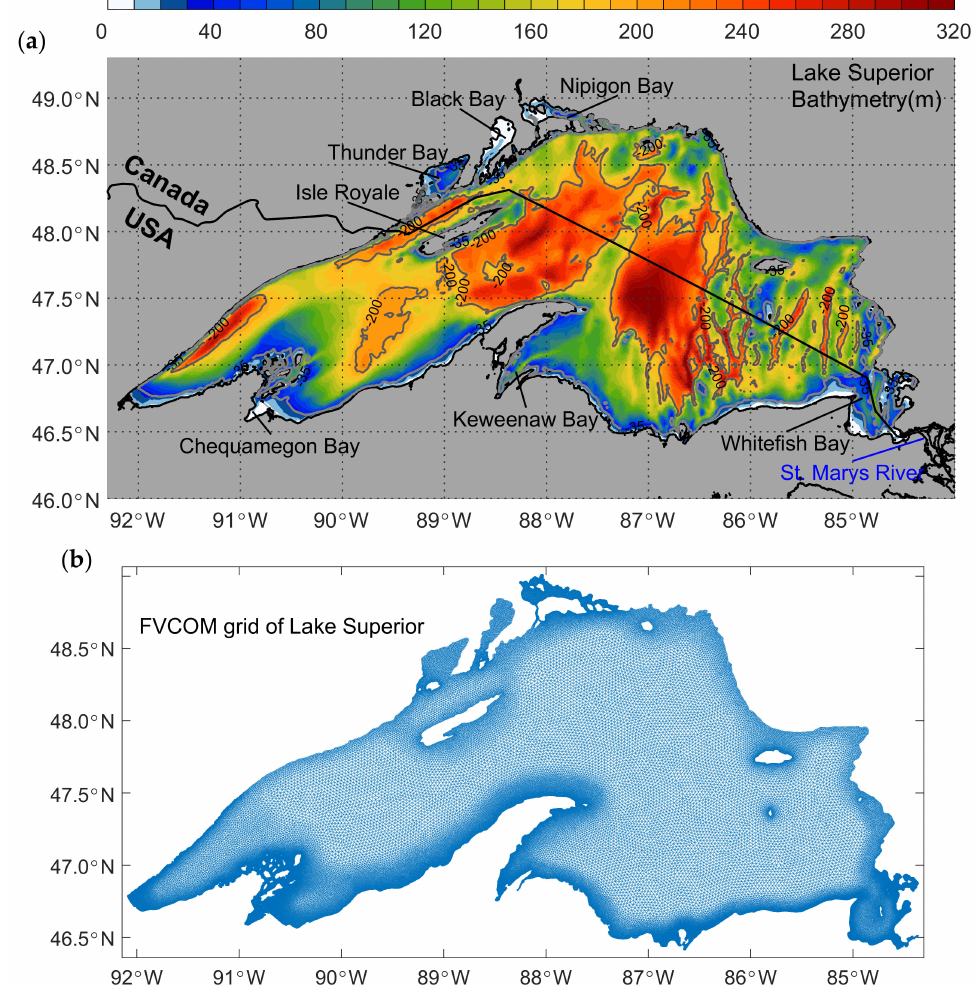
Figure 1. ( a ) Bathymetry (meter) of Lake Superior of the FVCOM. The two contours represent the isobaths of 35 m and 200 m. The 35 m isobath represents the criterion of depth for determining landfast ice in Lake Superior, and the 200 m isobath represents the deeper lake. Larger bays, including Nipigon Bay, Black Bay, Thunder Bay, Chequamegon Bay, Keweenaw Bay, and Whitefish Bay, Isle Royale, and the St. Marys River, which connects Lake Huron, are marked. ( b ) FVCOM mesh grid of Lake